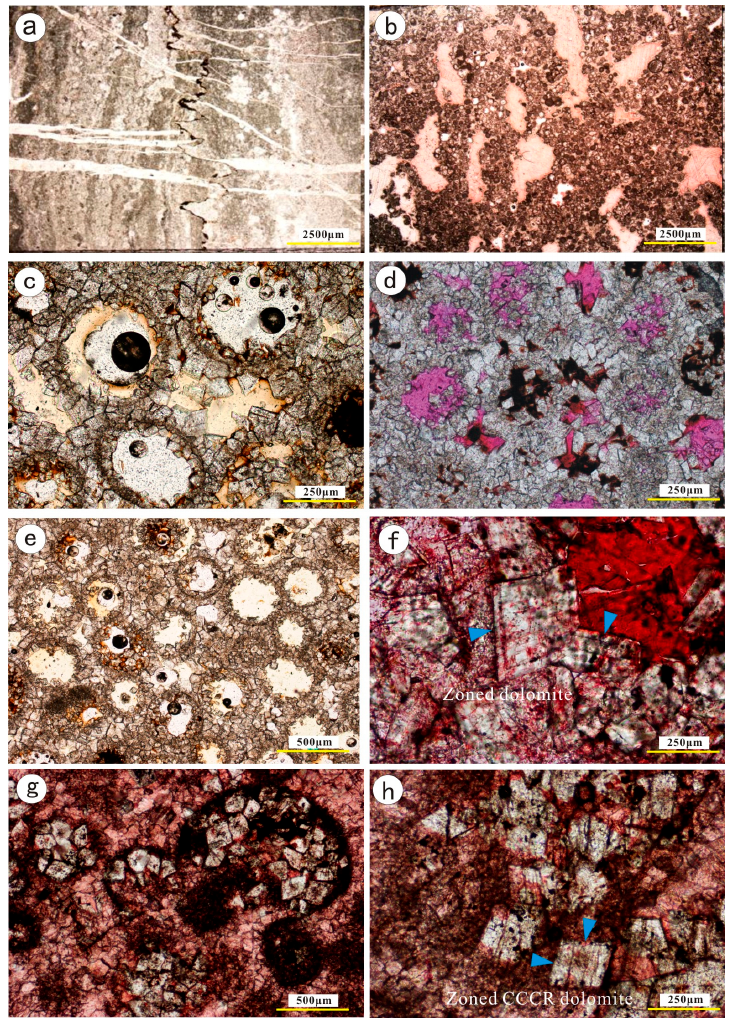
Figure 3. Microscopic features of dolomite from the Yudongzi outcrop. ( a ) Banded marly microcrystalline dolomite from the tidal flat facies with visible layers and stylolites, sample YA-80. ( b ) Marly microcrystalline tidal flat dolomite with dissolution pores filled with calcite, sample YA-77. ( c ) Residual oolitic dolomite from the platform-margin oolitic beach facies showing second-generation fine dolomite overgrowths on the rims of the first-generation comb-like silty dolomite, sample YA-B-12. ( d ) Residual oolitic dolomite from the platform-margin oolitic beach facies with partially filled intragranular and intergranular pores containing oil, sample YA-B-10. ( e ) Residual oolitic dolomite from the platform-margin oolitic beach facies showing comb-like dolomite, sample YA-B-12. ( f ) Residual oolitic dolomite from the platform-margin oolitic beach facies showing zoned dolomite, sample YA-B-2. ( g ) Cloudy cores and clear rims (CCCR) gray dolomite from the platform margin with strong replacement of oolites by one or more dolomite crystals, sample YA-74. ( h ) Zoned CCCR dolomite, sample